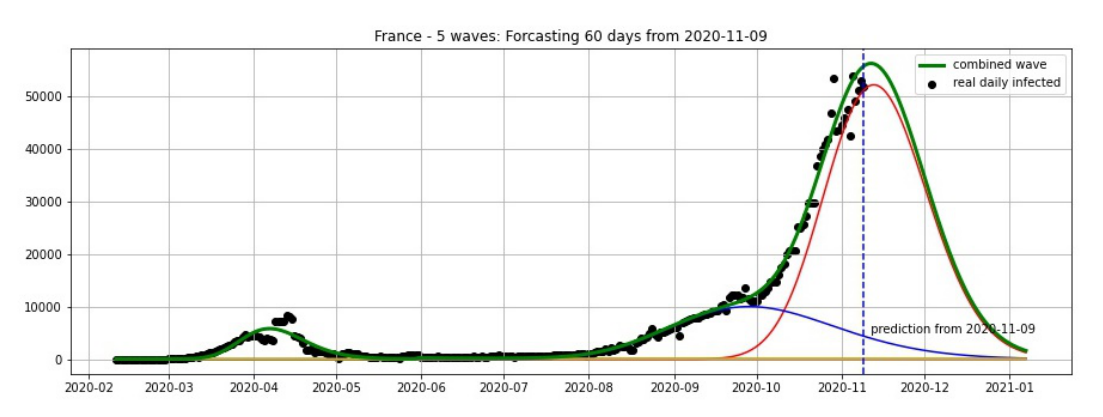
Figure 12. Italy: fitting and forecasting from 9 November with 5 wavelets. The green curve is the combination of other curves which are EF wavelets.